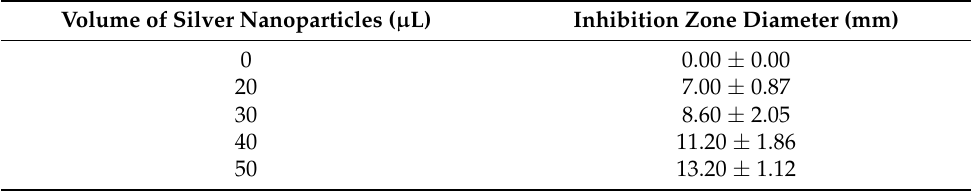
Table 1. Diameter of inhibition zone of silver nanoparticles against B. maydis.